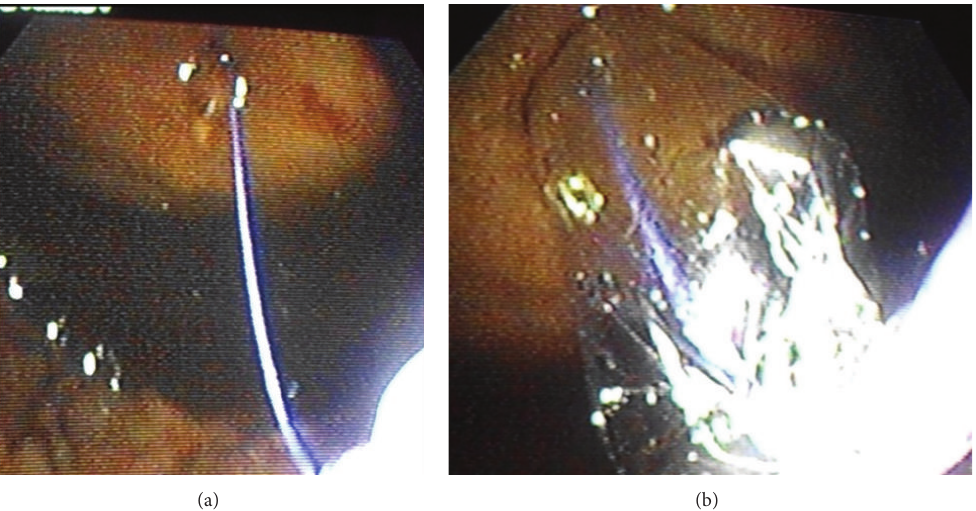
Figure 4: A balloon dilator was railroaded over a guidewire (a) to dilate the transmural tract to 16mm